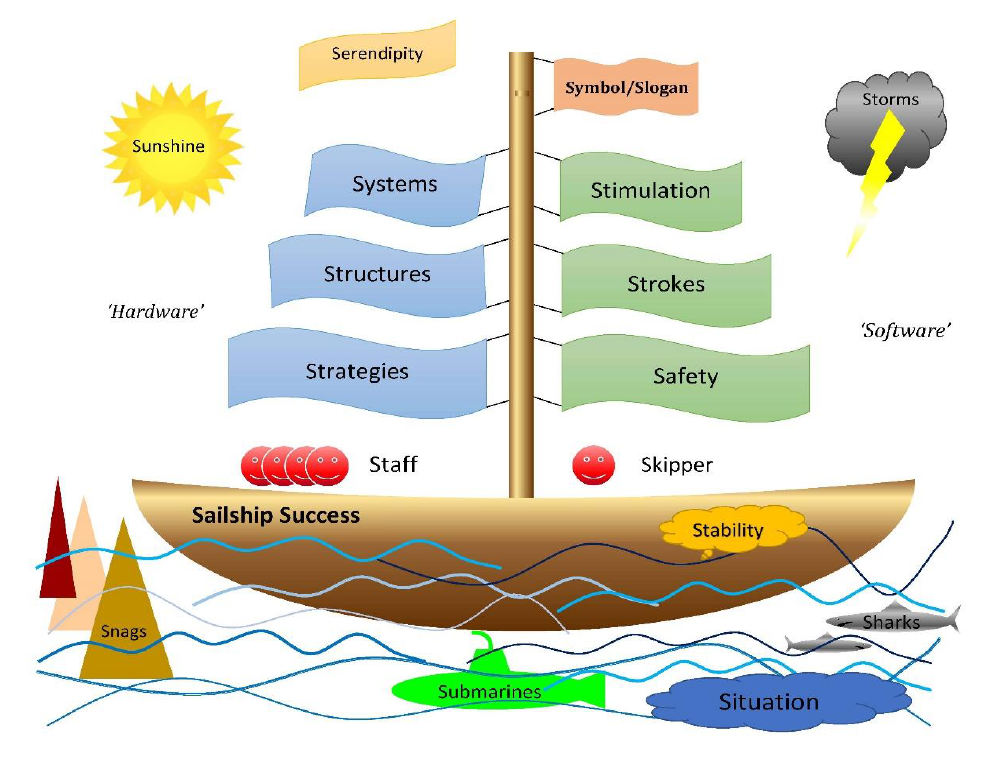
Figure 20: Sailship Success (Hay, 2017,